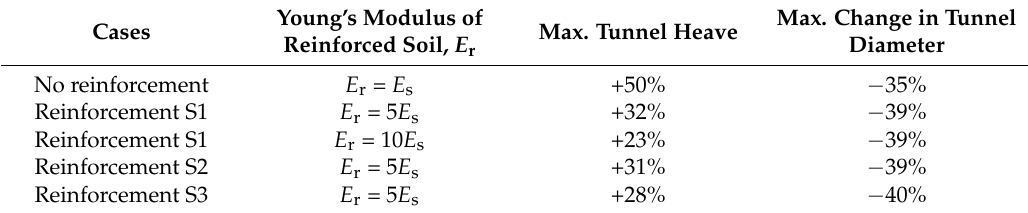
Figure 6. Measured and computed ( a ) tunnel heave and ( b ) maximum tunnel heave with different reinforced soil Young’s moduli. Table 2. Comparison of computed and measured